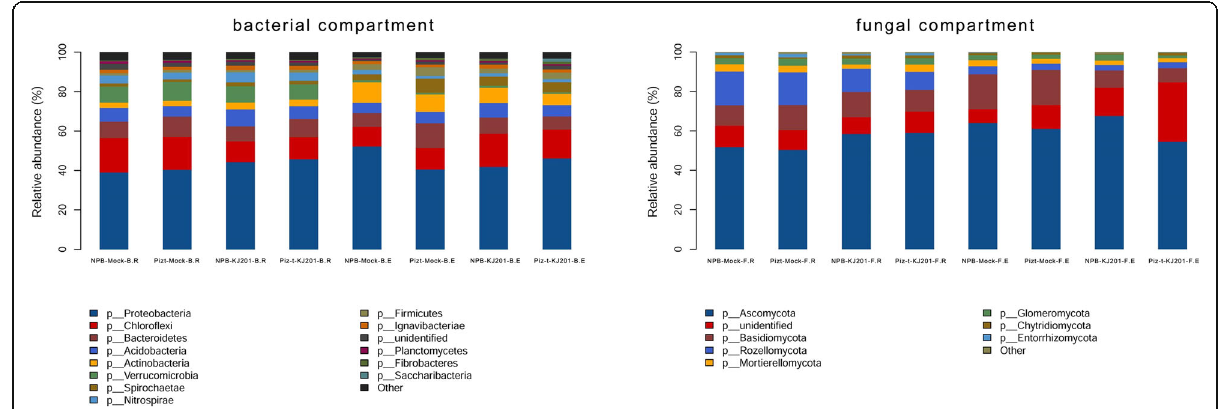
Fig. 2 Histograms of phyla abundances in each compartment. Relative abundance plots of the fungal and bacterial taxa with greater than 1.0% of total read abundance after being pooled based on each compartment. The horizontal ordinate is the name of the sample and the ordinate is the relative abundance of the species in the